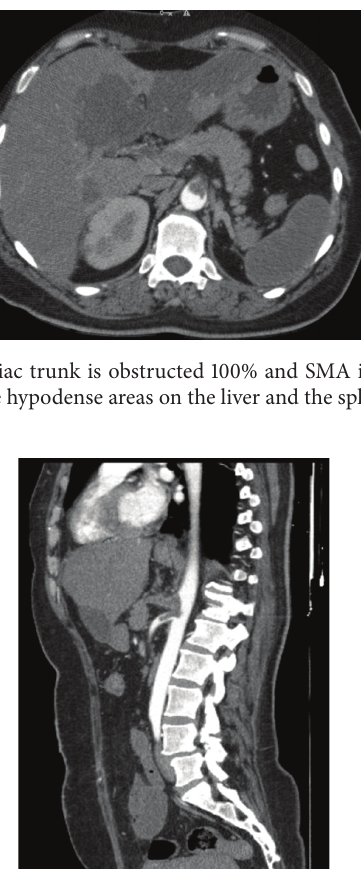
performed between jejunum and ileum segments. On the postoperative 4th day, she was reoperated on after detecting bile drainage. In the operation, there was found to be a leakage in the anastomosis and jejunostomy with mucous fistula was performed. In the intensive care unit, she died with disseminated intravascular coagulation on the postoperative 3rd